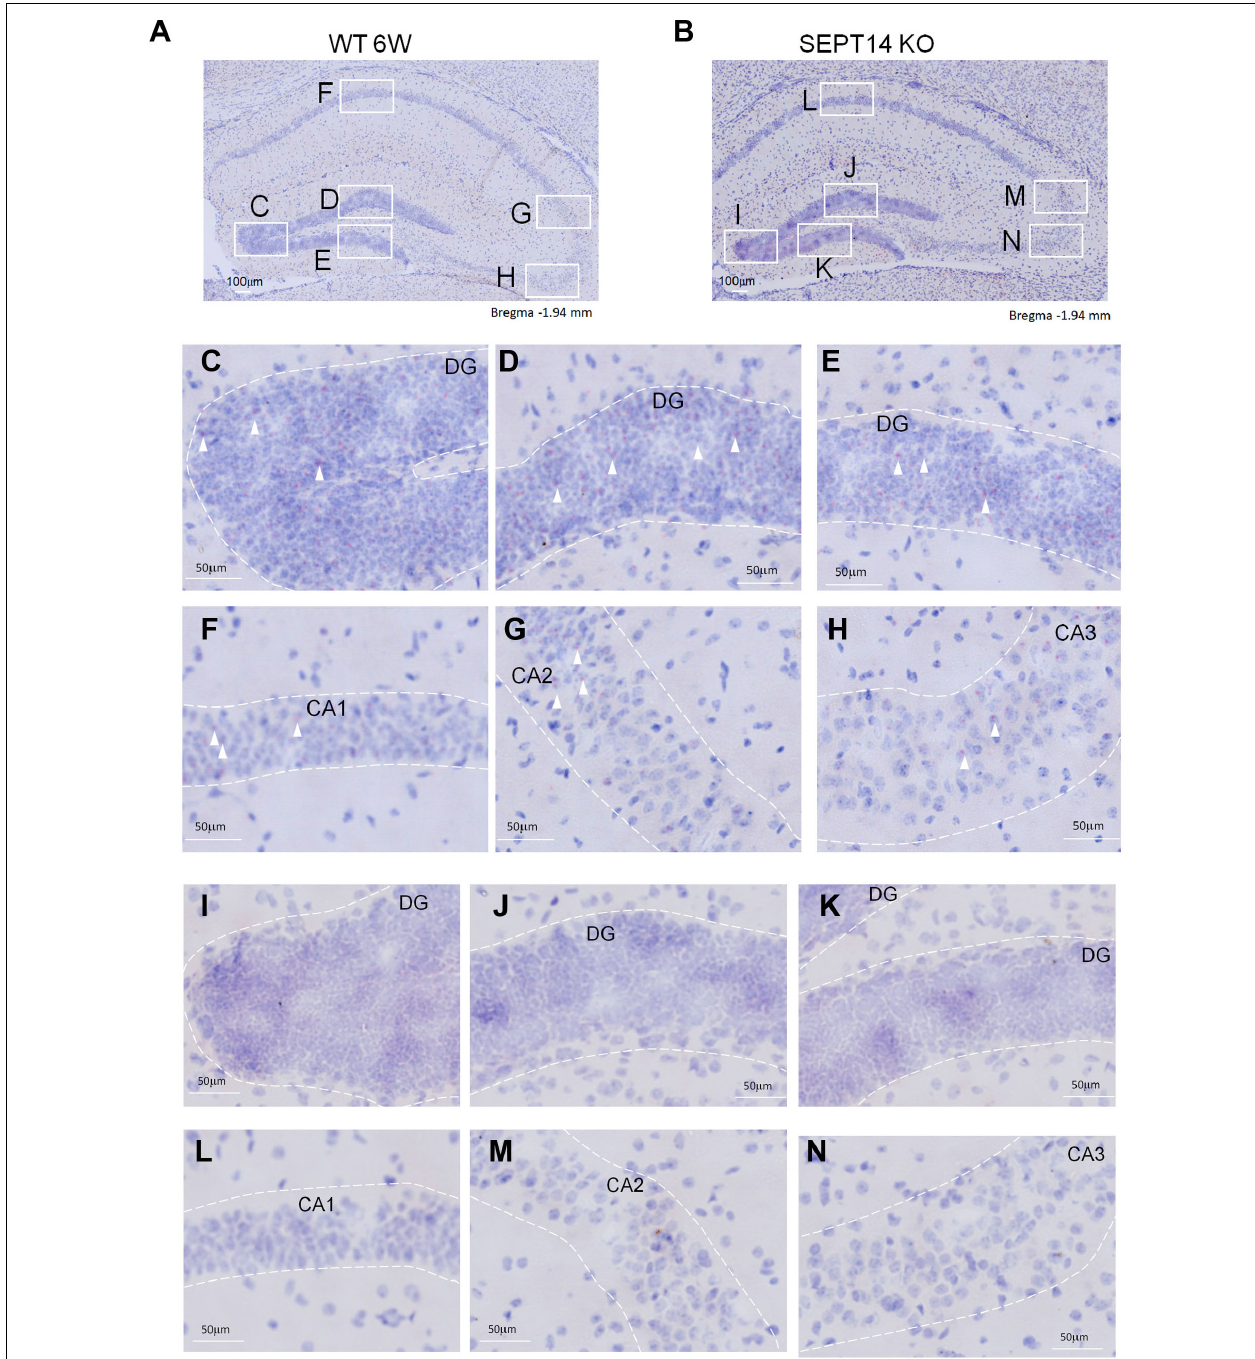
FIGURE 1 | Distribution of Septin-14 mRNA in the hippocampus. (A,C–H) BaseScope images of hippocampus sections from WT mice (A) . The outlined areas were enlarged to show regions of DG (C–E) , CA1 (F) , CA2 (G) , and CA3 (H) in panel A . Punctated red dots indicate the presence of Septin-14 mRNAs (white arrows). (B,I–N) BaseScope images of hippocampus sections from SEPT14 KO mice (B) . The outlined areas were enlarged to show regions of DG (I–K) , CA1 (L) , CA2 (M) , and CA3 (N) in panel (B) .